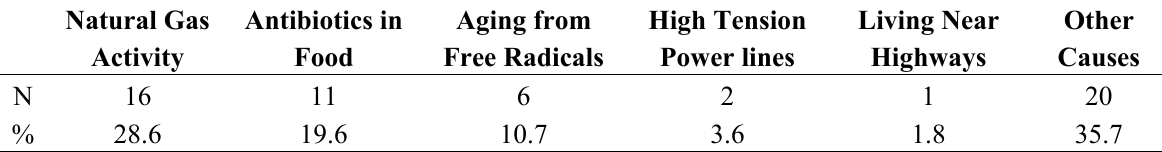
Table 2. Reported Frequency of Environmental Reasons for Medical Problems Among 72 Study